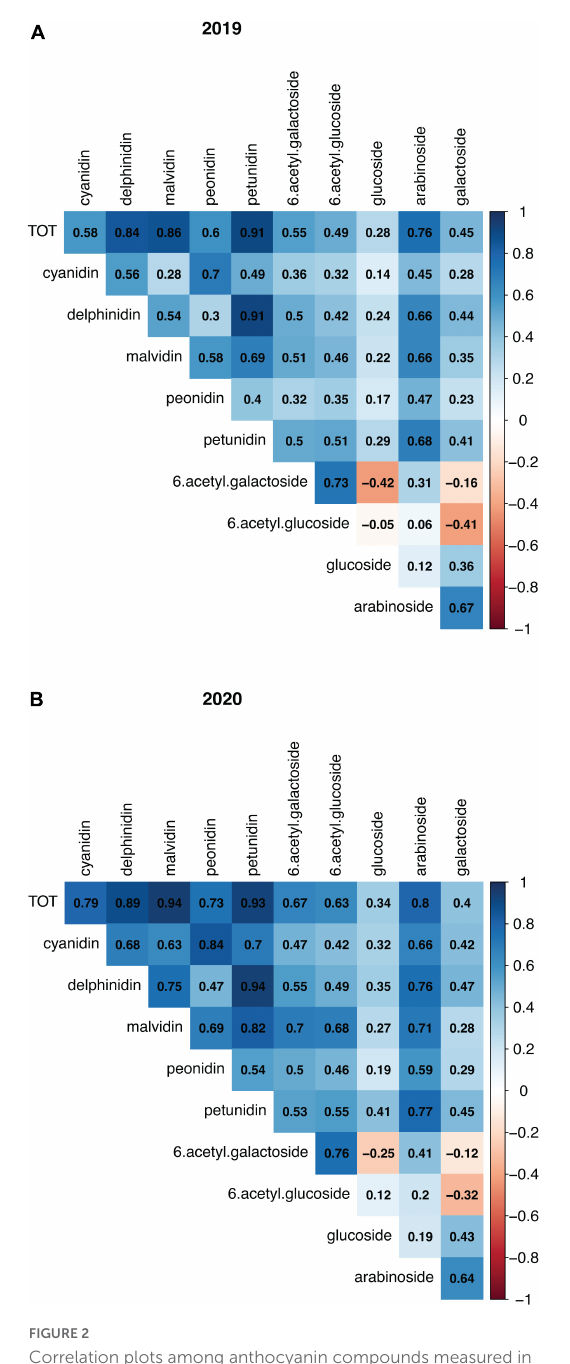
FIGURE2 Correlation plots among anthocyanin compounds measured in “Hortblue Petite” × “Nui” population. The total concentrations for 10 groups of anthocyanin, as well as overall anthocyanin (TOT), in 2019 (A) and 2020 (B) were used for pairwise correlations.